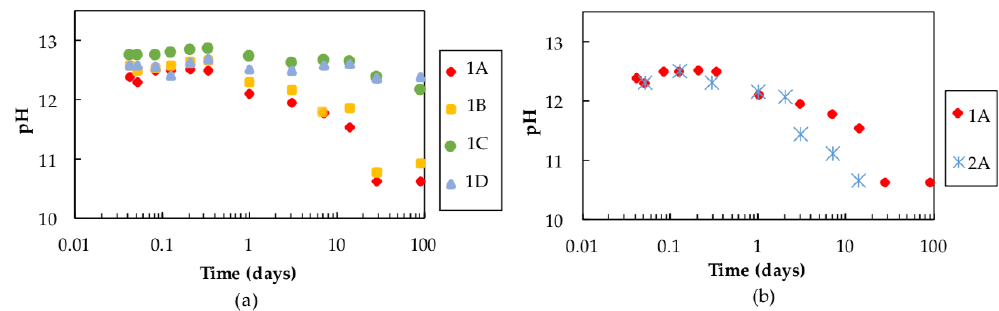
Figure 12. pH changes of the pore water in ( a ) mixtures 1A, 1B, 1C, and 1D and ( b ) mixtures 1A and 2A during the